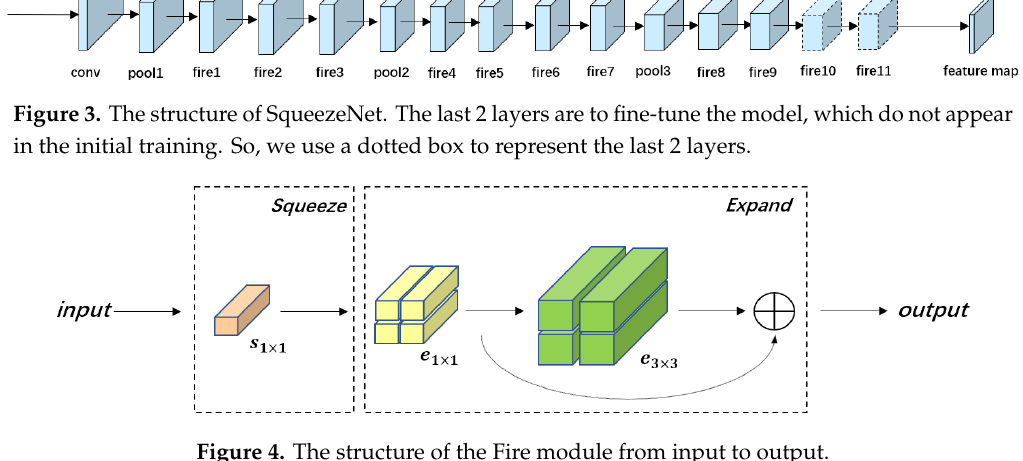
Figure 4. The structure of the Fire module from input to output.